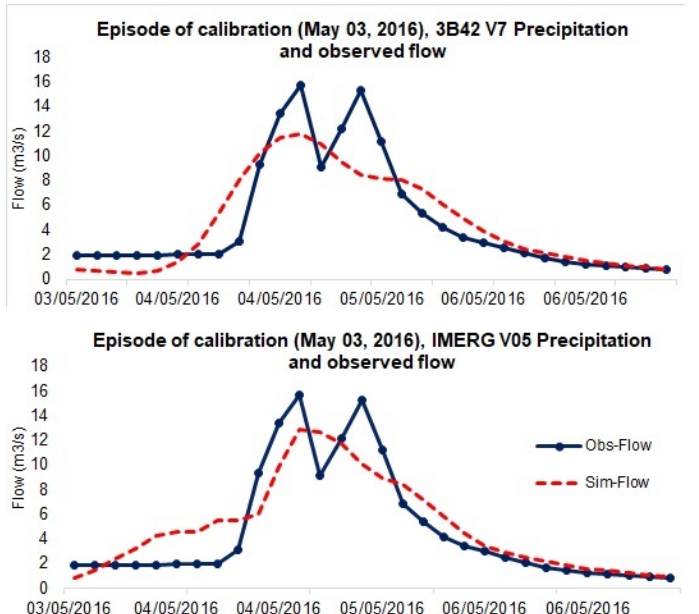
Figure 6. Calibration of the episode 3 May 2016, using 3B42V7 and IMERG V05 rainfall products and observed runoff data as input.